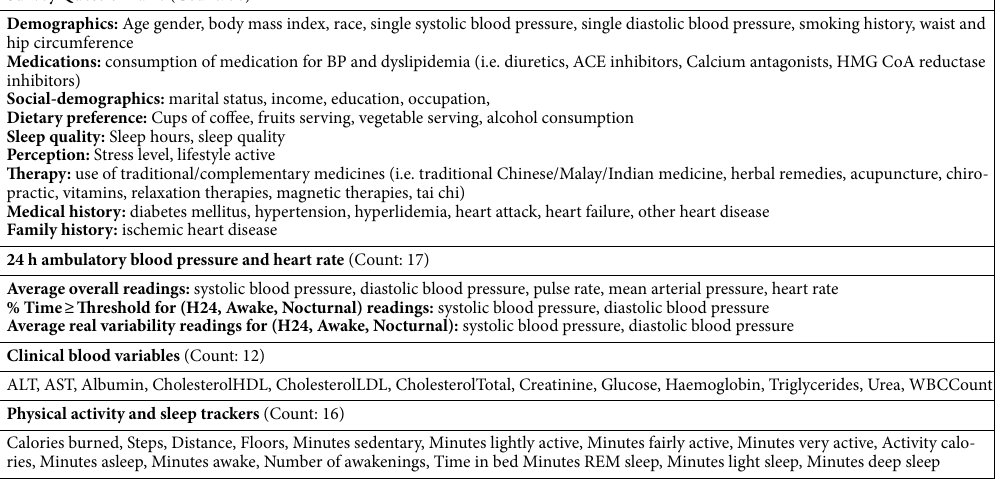
Table 1. List of risk factors used for prediction in this study.